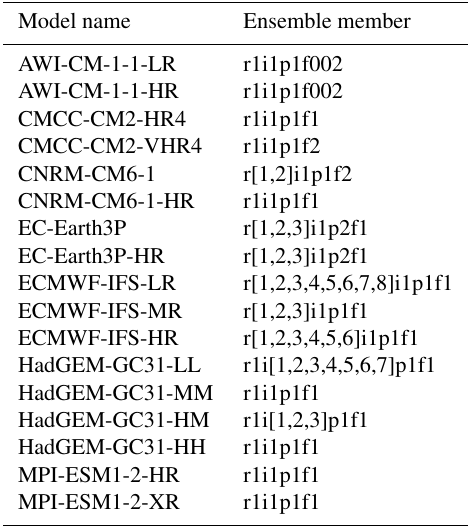
Table B2. HighResMIP models used in this paper.